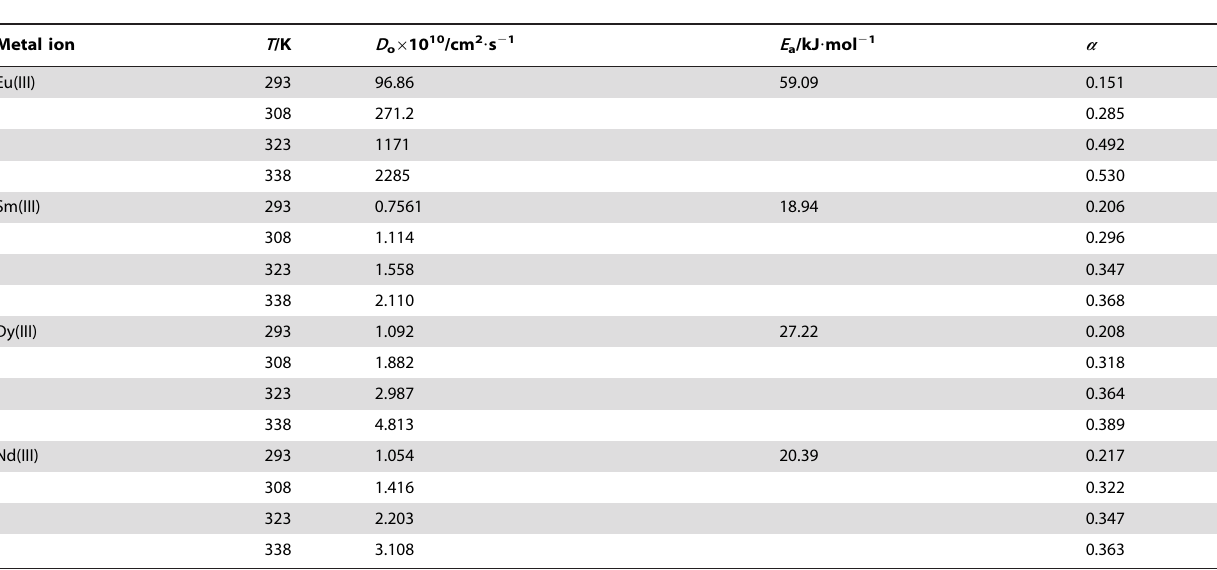
Table 2. Diffusion coefficients ( D o ), transfer coefficients ( a ) and energy of activation ( E a ) of Eu(III), Sm(III), Dy(III) and Nd(III) in BmimBr at different